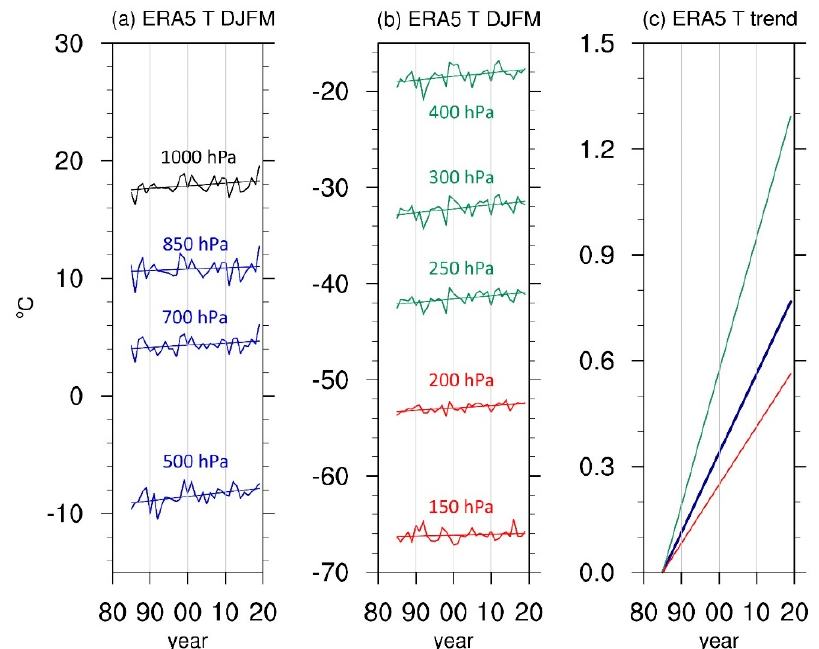
Figure 7. Decadal trend of the ( a , b ) mean temperature from December to next March (DJFM) at each pressure layer, ( c ) each group of pressure layers (subtracting the trend value of the first observation year) through the ERA5 data, unit: °C. The colors indicate the grouped pressure layers (black: 1000 hPa; blue: 850 hPa to 500 hPa; green: 400 hPa to 250 hPa; red: 200 hPa to 150 hPa). The thin line at each pressure layer denotes the corresponding trend of the variations.